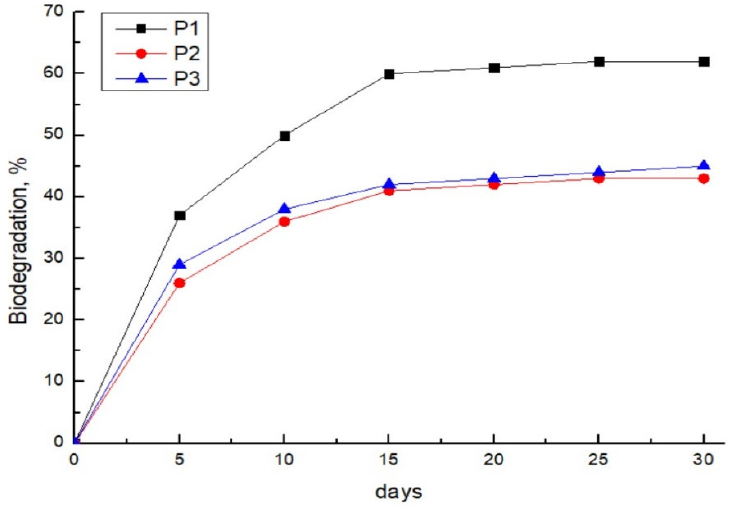
Figure 4. Aerobic biodegradation of pectin-based cryogels.